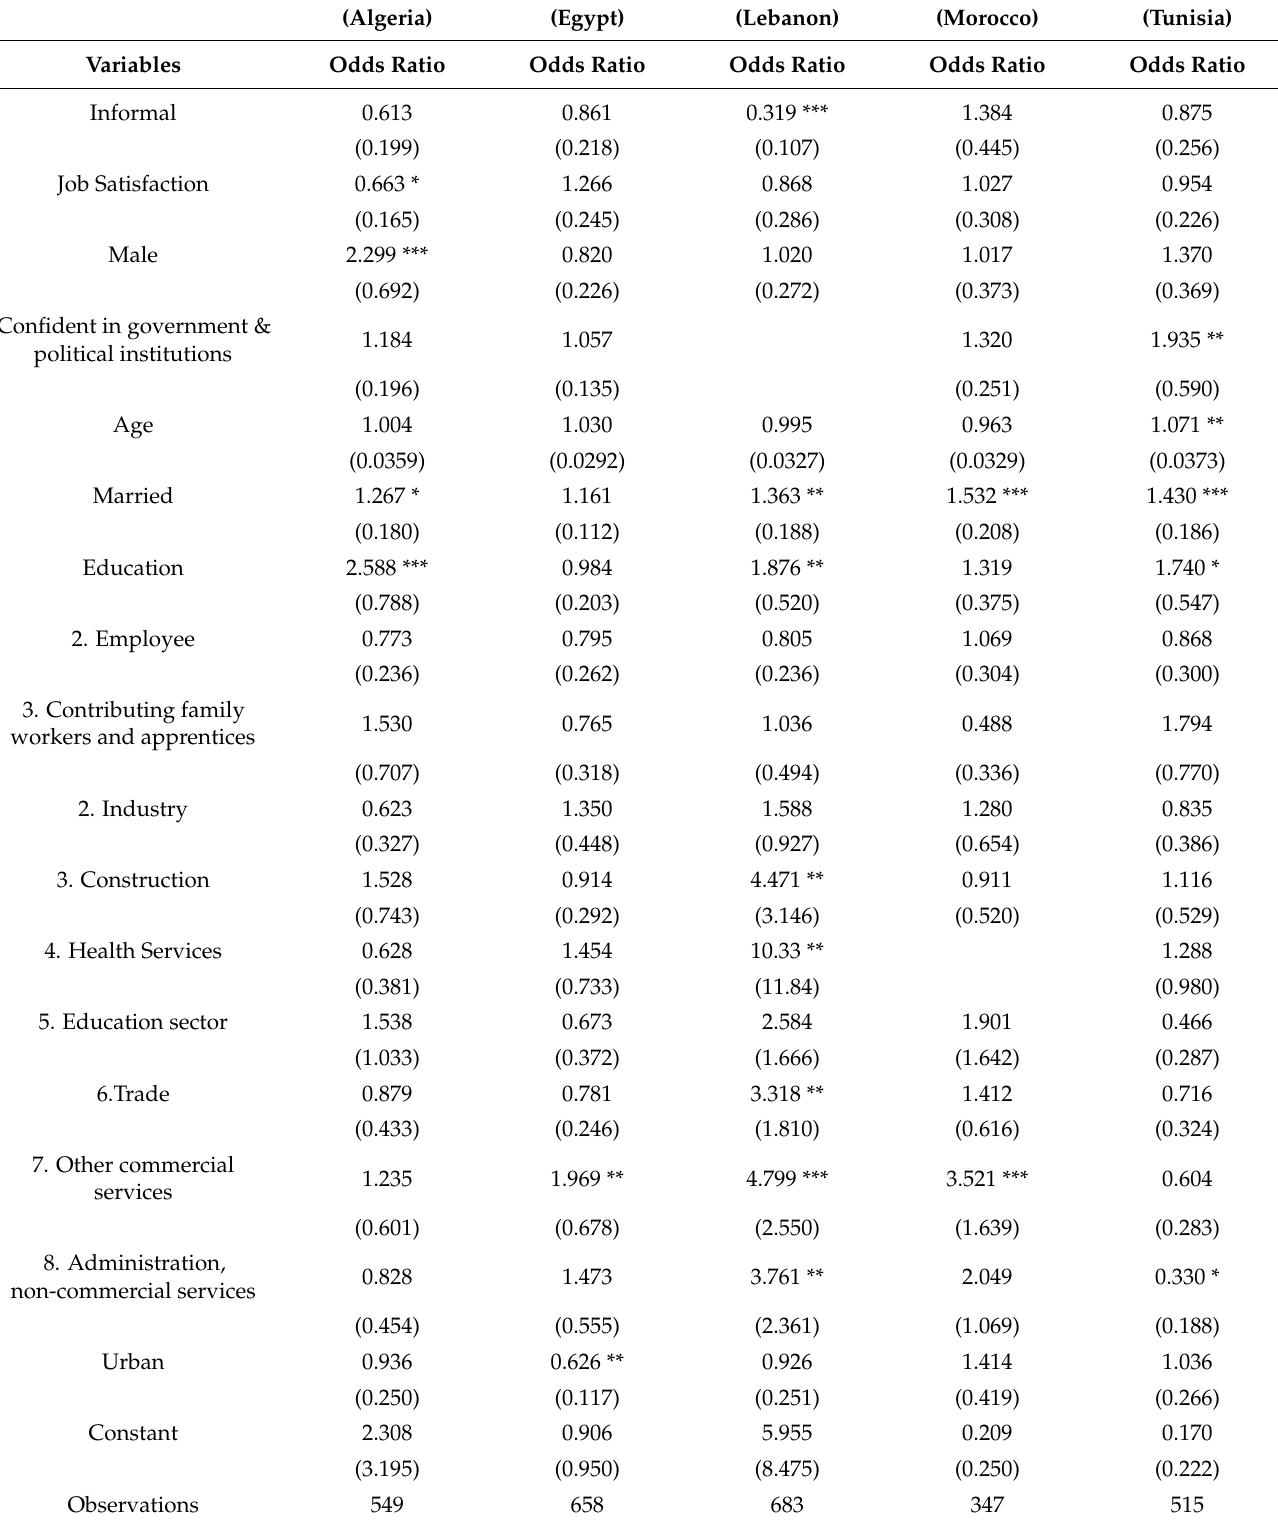
Table A5. Logistic regression on the “talk politics” index by